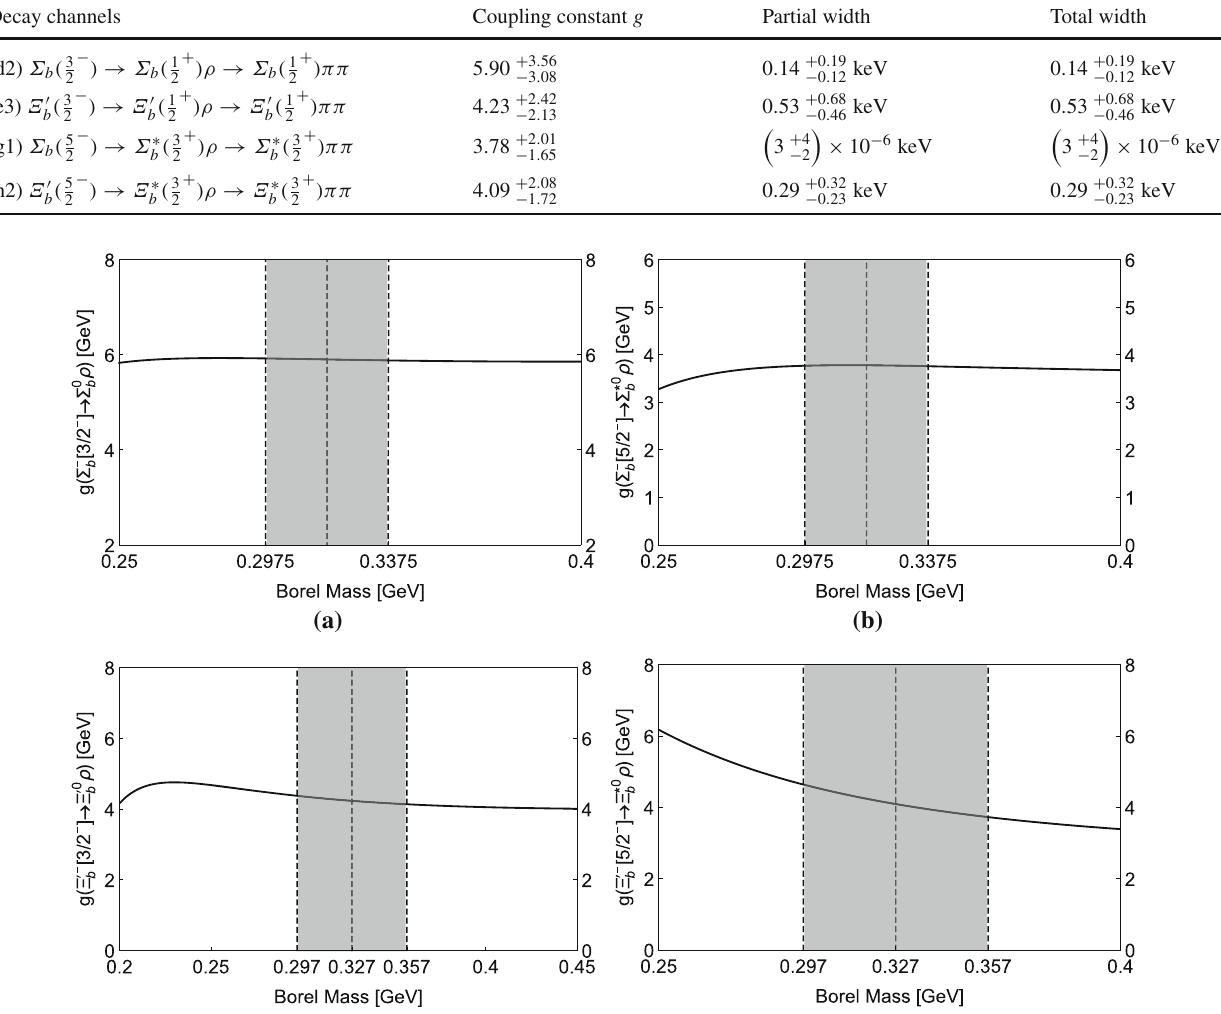
Table 4 S -wave decays of P -wave bottom baryons belonging to the doublet [ 6 F , 2 , 1 ,λ ] into ground-state bottom baryons and vector mesons Decay channels Coupling constant g